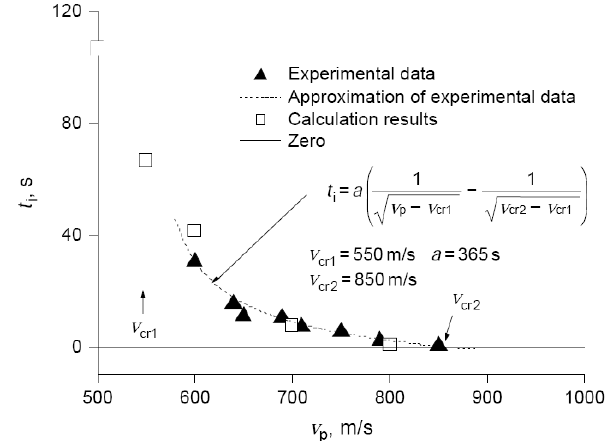
Figure 4: Induction (deposition delay) time versus the mean impact velocity of aluminum particles on a polished copper substrate